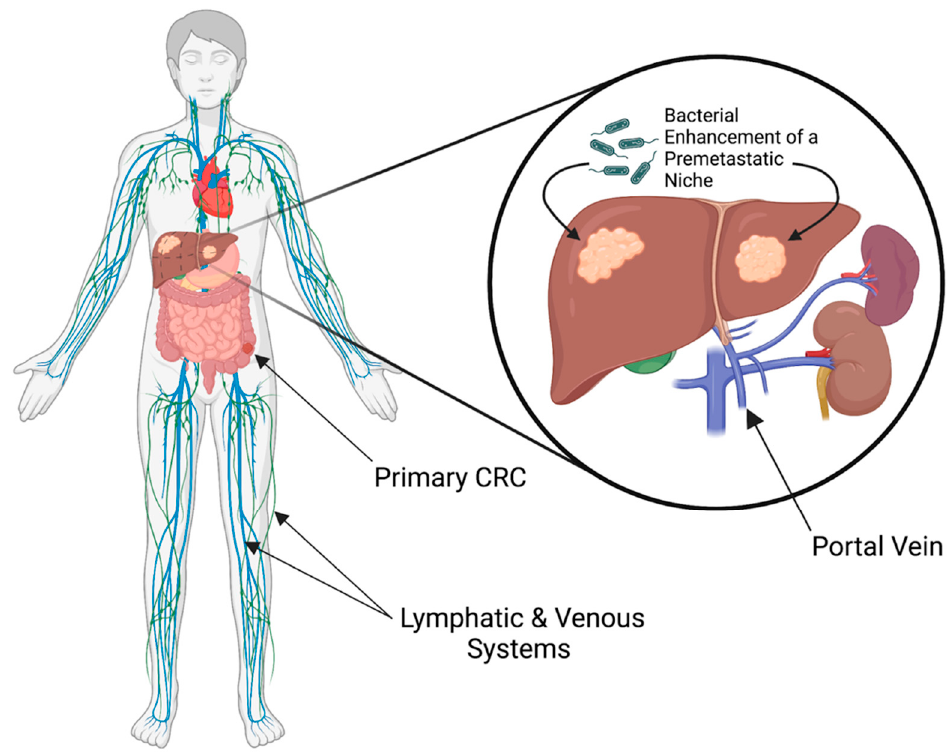
Figure 4. Bacterial influence in the metastatic cascade at the primary tumor and formation of a premetastatic niche at the site of metastasis. Figure created using biorender.